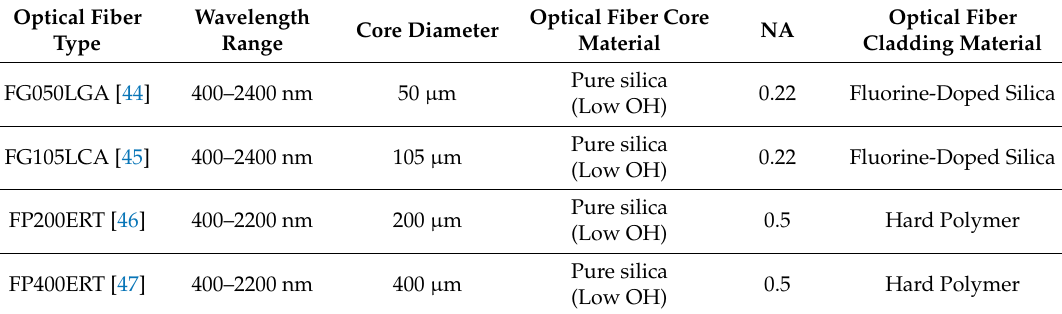
Table 1. Optical fiber